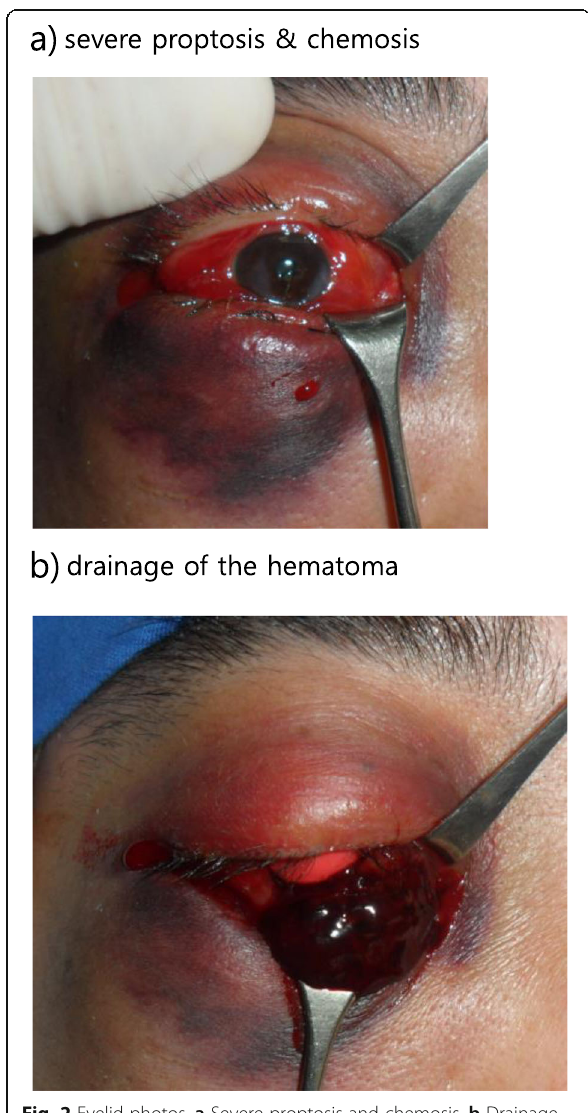
Fig. 2 Eyelid photos. a Severe proptosis and chemosis. b Drainage of the